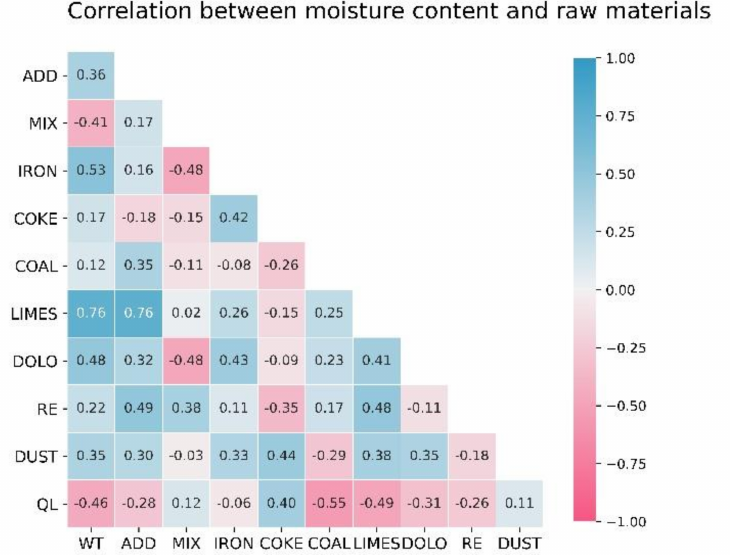
Figure 2. Correlations between moisture contents of raw